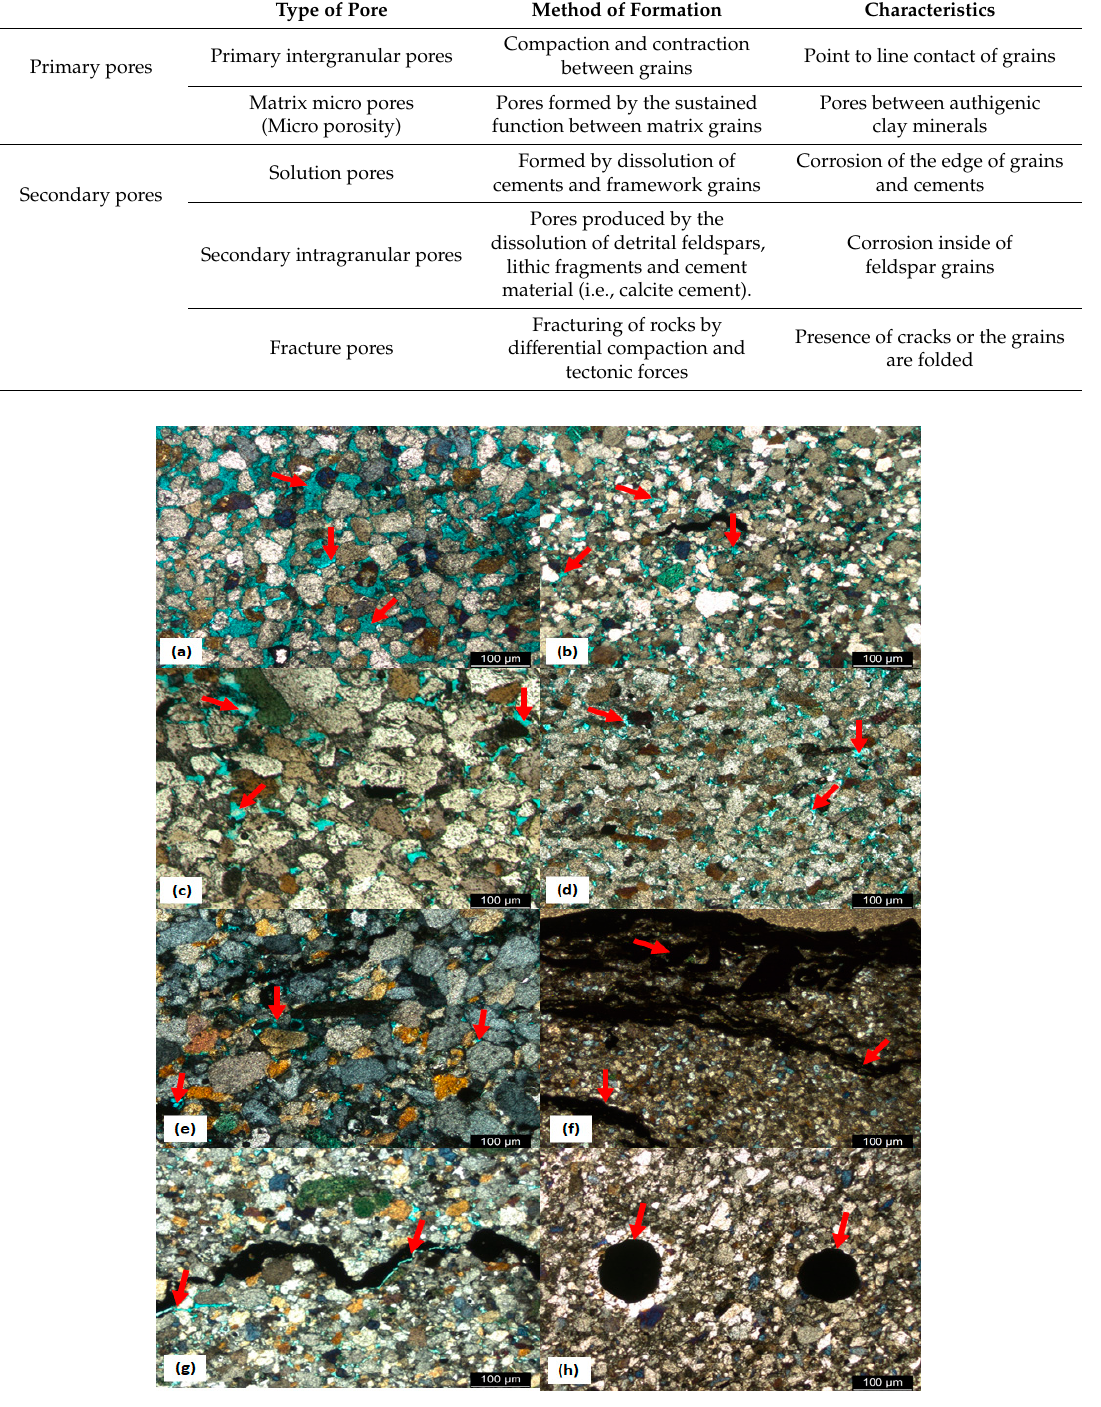
Figure 7. Thin section photomicrograph of sandstone showing some reservoir properties: ( a ) Primary pore spaces (green areas, red arrows) in Borehole E-AH1 at a depth of 2477 m; ( b ) pore spaces (green areas, red arrows) in Borehole E-AJ1 at a depth of 2704 m; ( c ) Pore spaces (green areas, red arrows) in Borehole E-BA1 at a depth of 2835 m; ( d ) Pore spaces (green areas, red arrows) in Borehole E-BB1 at a depth of 2852 m; ( e ) Pore spaces (Top: hydrocarbon fills to previously fractured zone, red arrows point to pore space) in Borehole E-D3 at a depth of 3528 m; ( f,g ) Solid bitumens filling the fractured pores (red arrows) in Borehole E-BB1; ( h ) Oil emplacement in Borehole E-AJ1.